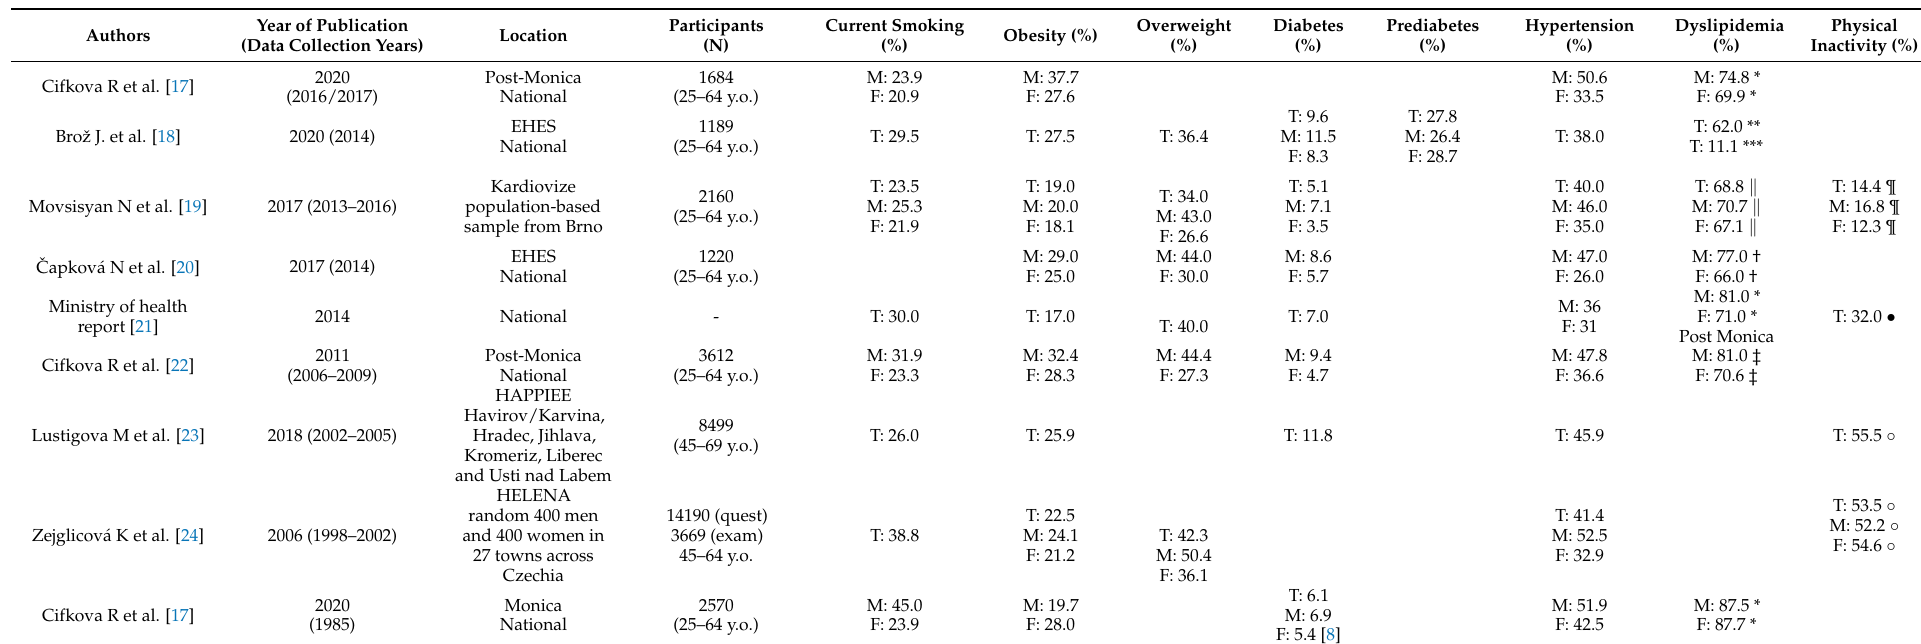
Table 2. Studies of prevalence of cardiometabolic risk factors in adults of